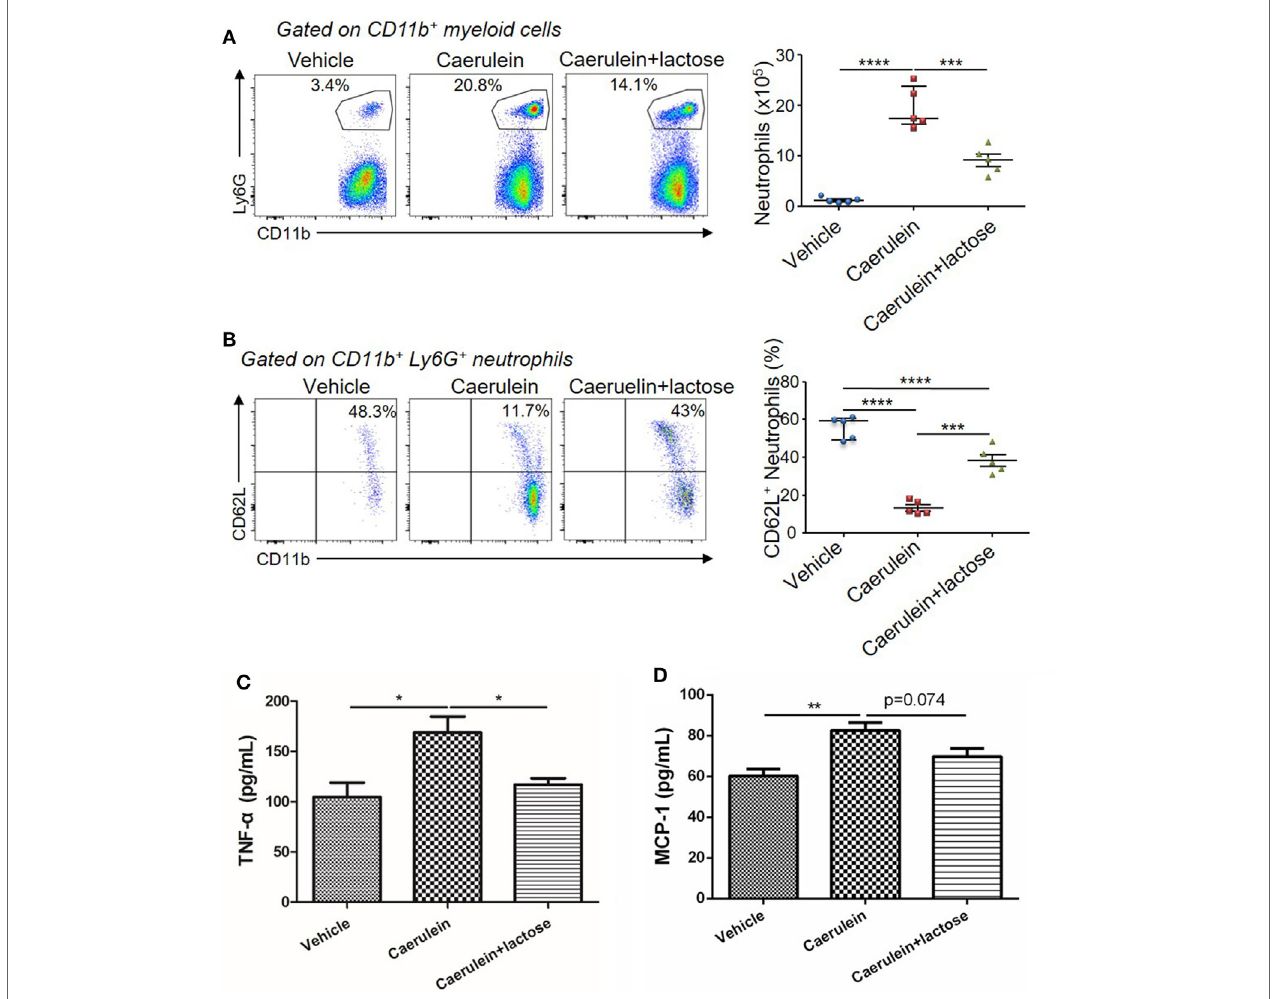
FigUre 3 | Lactose modulates neutrophil infiltration and activation during early acute pancreatitis and cytokine/chemokine production from peripheral neutrophils. Female BALB/c mice were treated with caerulein together with or without lactose and 3 h later cells were recovered from the pancreas. Cells were directly stained for the expression of CD45, Ly6G, CD11b, and CD62L. (a) The frequency and absolute number of neutrophils per pancreas were shown. (B) The frequency of CD62L + neutrophils in the pancreas was shown. Results are representative or median values ± interquartile range from two independent experiments with a minimum of five independent mice. (c,D) Peripheral neutrophils were isolated, and incubated with lipopolysaccharides (1 µg/ml) for 3 h and the levels of tumor necrosis factor alpha (c) and monocyte chemotactic protein-1 (D) were analyzed by ELISA. Data are mean ± SEM from at least three independent experiments of at least five independent mice in each group. * p < 0.05, ** p < 0.01 by one-way analysis of